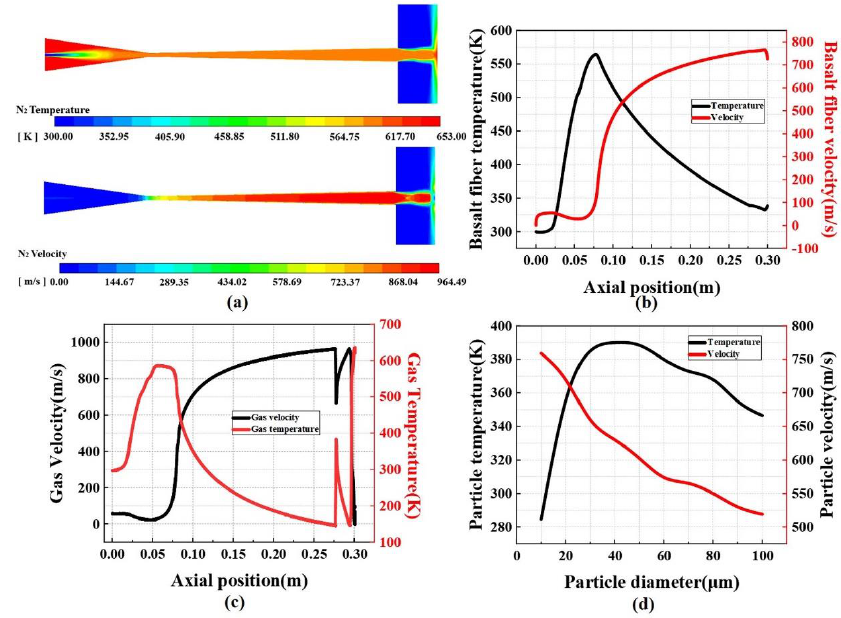
Figure 5. ( a ) Temperature and velocity variation of N2 in the nozzle. ( b ) Variation of CBF velocity and temperature along the X -axis. ( c ) Variation of velocity and temperature of N2 along the X -axis. ( d ) Velocity and temperature of aluminum powder with different